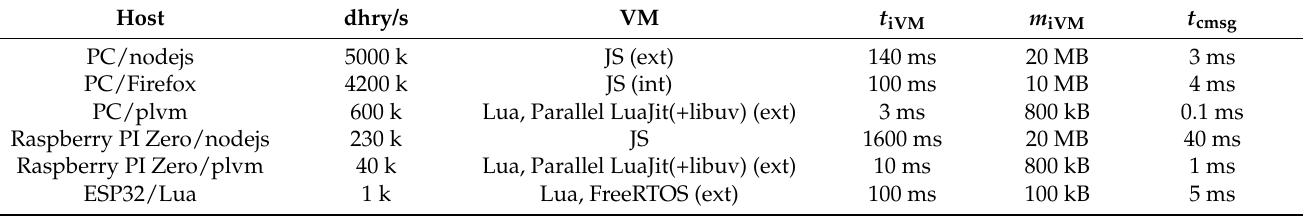
Table 1. Selected experimental results of VM performance (dhrystones measured by the